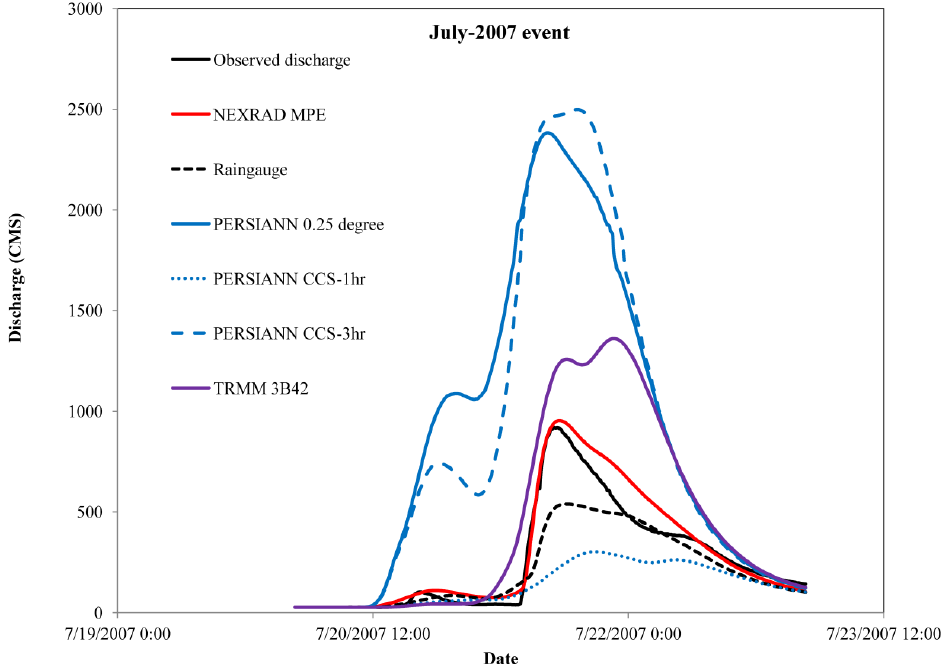
NSE (0.85) and R (0.99) values. The rain gauge simulated streamflows were able to reproduce the peak discharge and runoff volume with low errors and high NSE (0.89) and R (0.97) values. Figure 11. Comparison of observed and simulated streamflow for the July 2007 storm event.